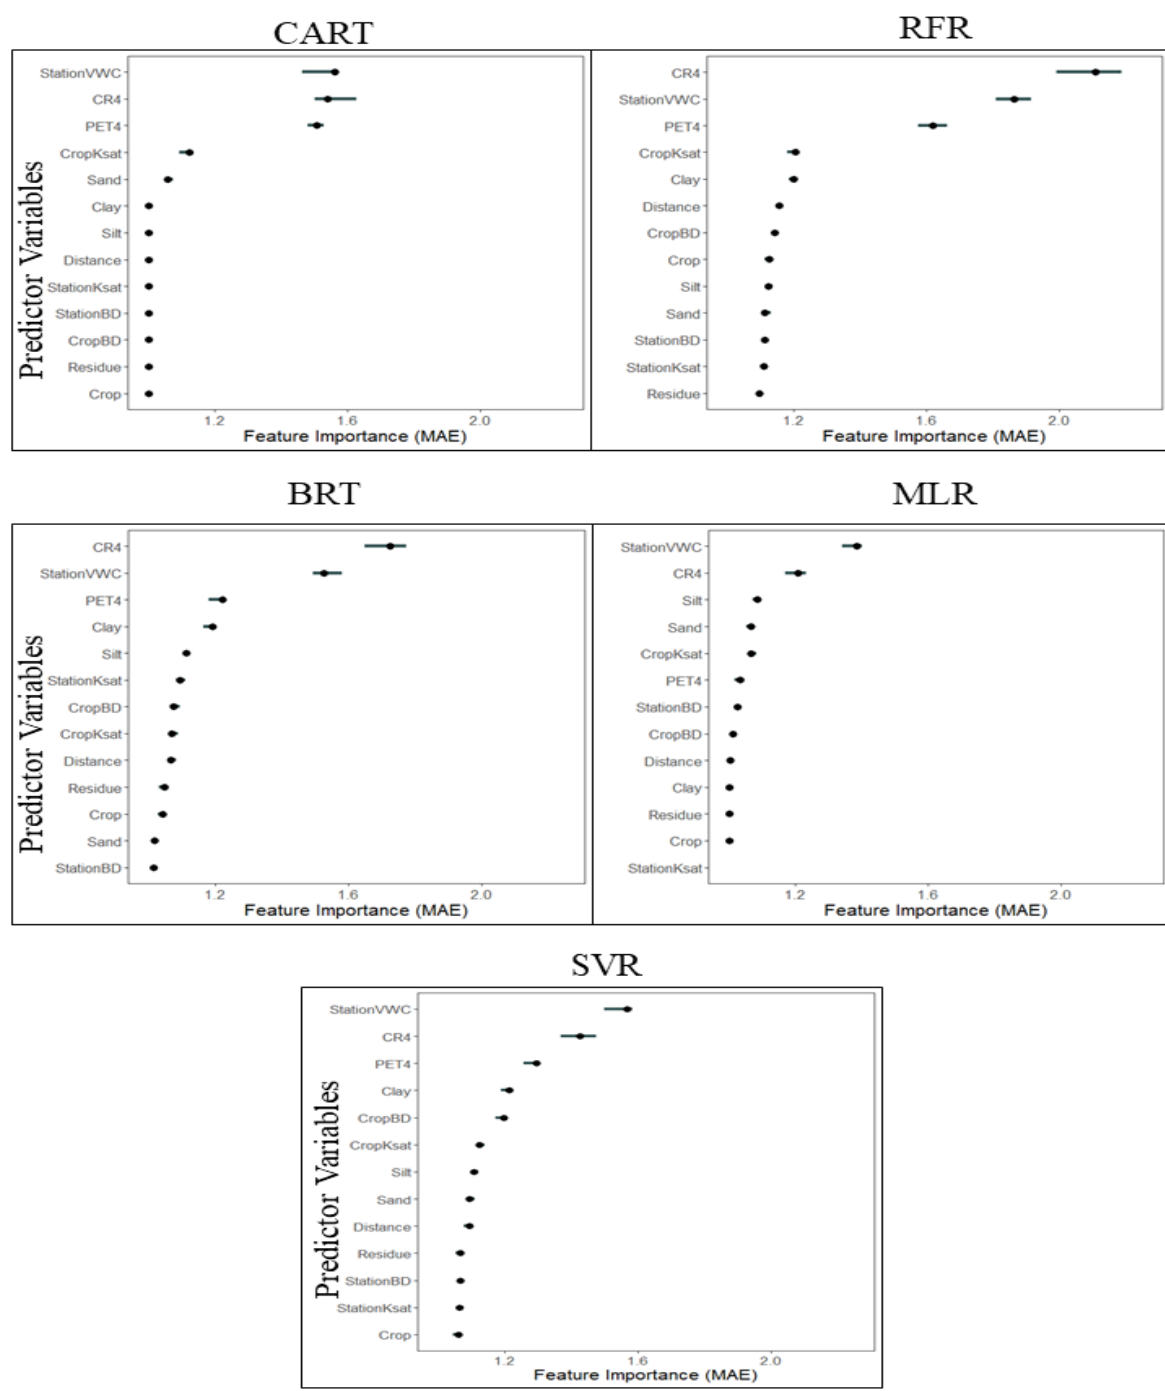
Figure 5. Feature importance of predictor variables for 5 different machine learning model based on the loss of mean absolute error (MAE) along with 5th to 95th percentile values. Algorithms included classification and regression trees (CART), multiple linear regression (MLR), random forest regression (RFR), support vector regression (SVR), and boosted regression trees (BRT).